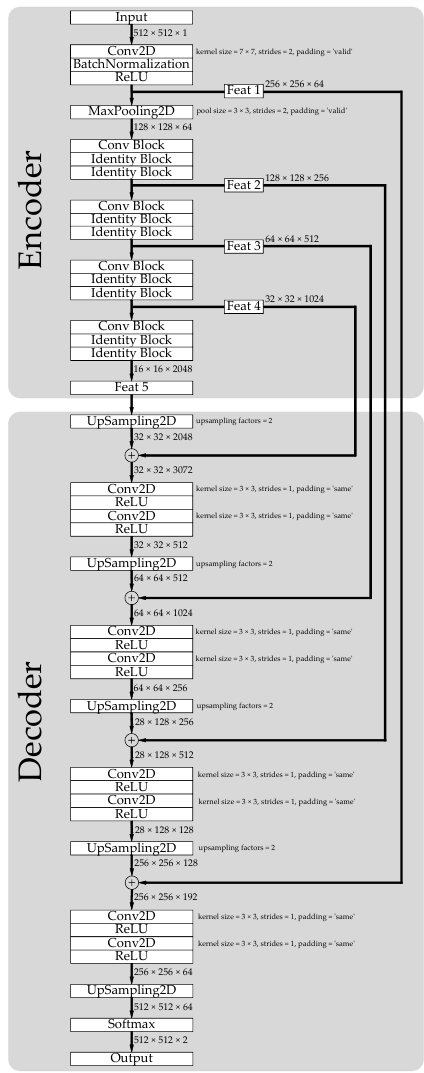
Figure 4. ResNet semantic segmentation network with UNet